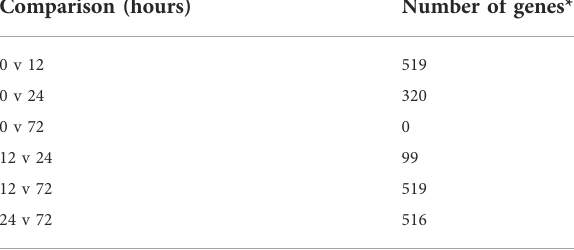
TABLE 1 Pairwise comparisons for differential gene expression in response to DEX. *Adjusted p < 0.05, n = 3